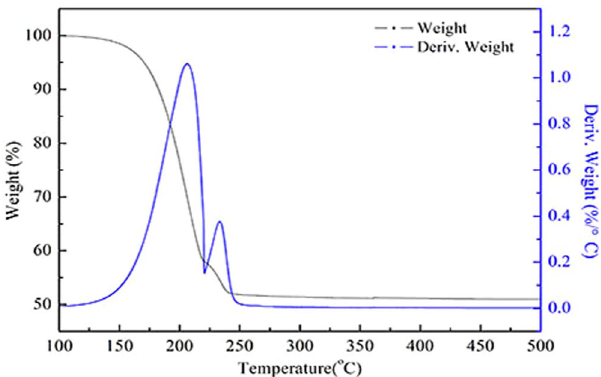
Figure 5. The thermal analysis curves of the novel fluorocarbon surfactant.